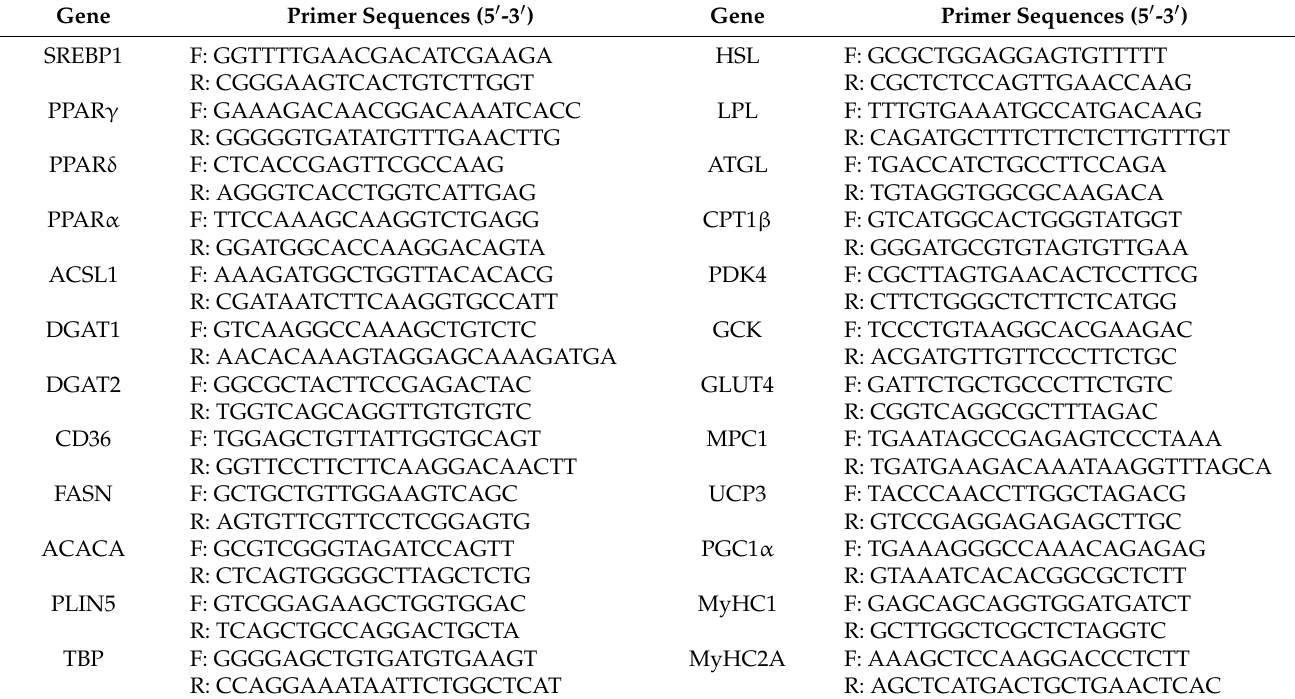
Table 3. List of primer sequences for reverse transcription-quantitative